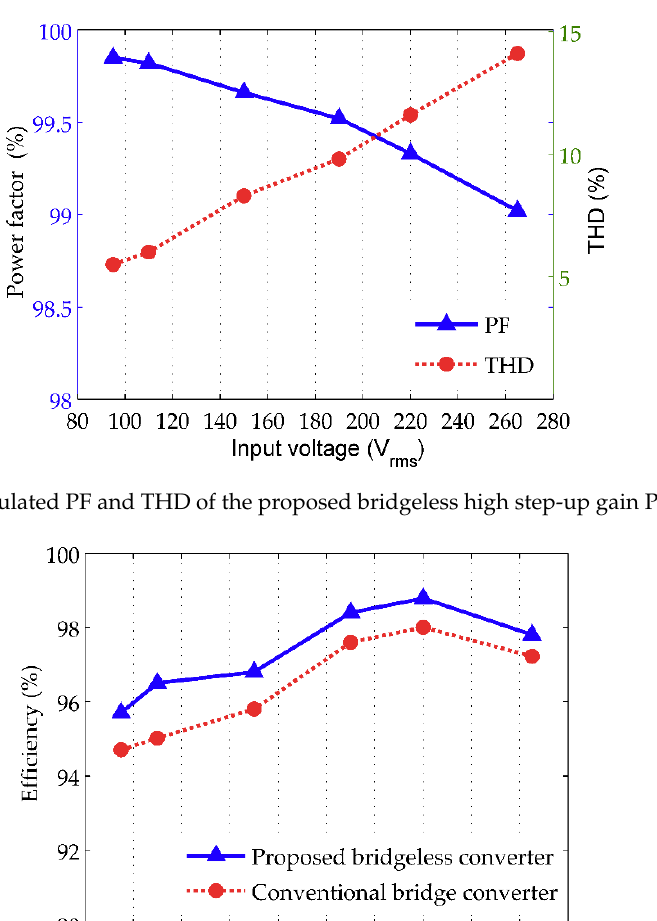
Figure 10. The key time-domain waveforms at v in = 220 V rms .